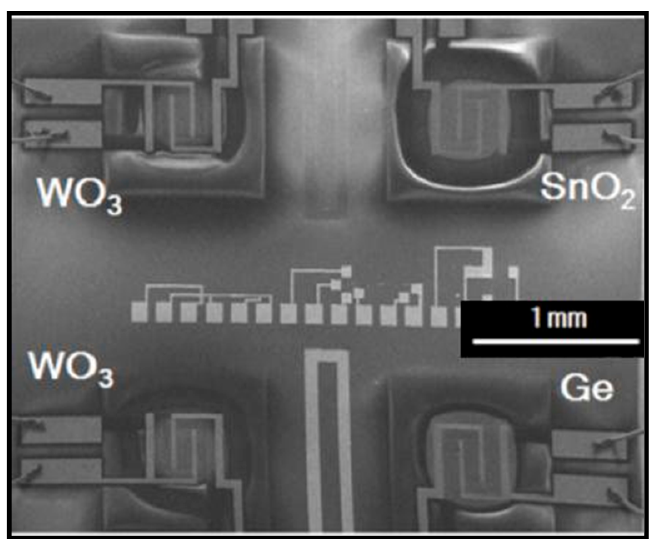
Figure 1. SEM image of WO3, Ge and SnO2 NWs site-selectively